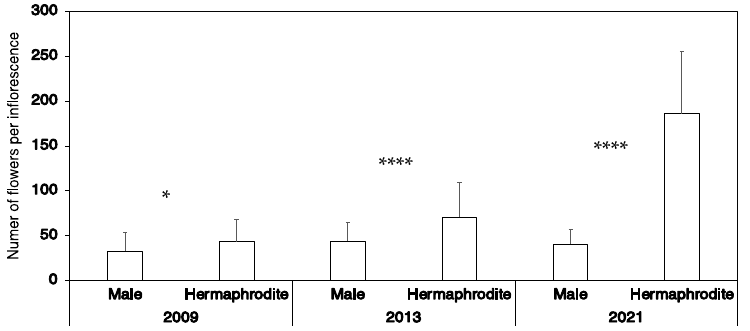
Figure 4. The number of hermaphroditic and male flowers per inflorescence on andromonoecious trees in 2009, 2013 and 2021. Bars indicate standard error. *, p < 0.05; ****, p < 0.0001.